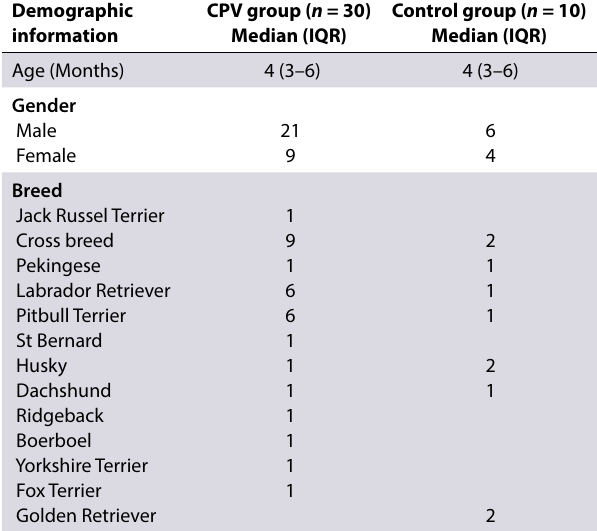
Table I: Demographic characteristics of the CPV and control groups Demographic information